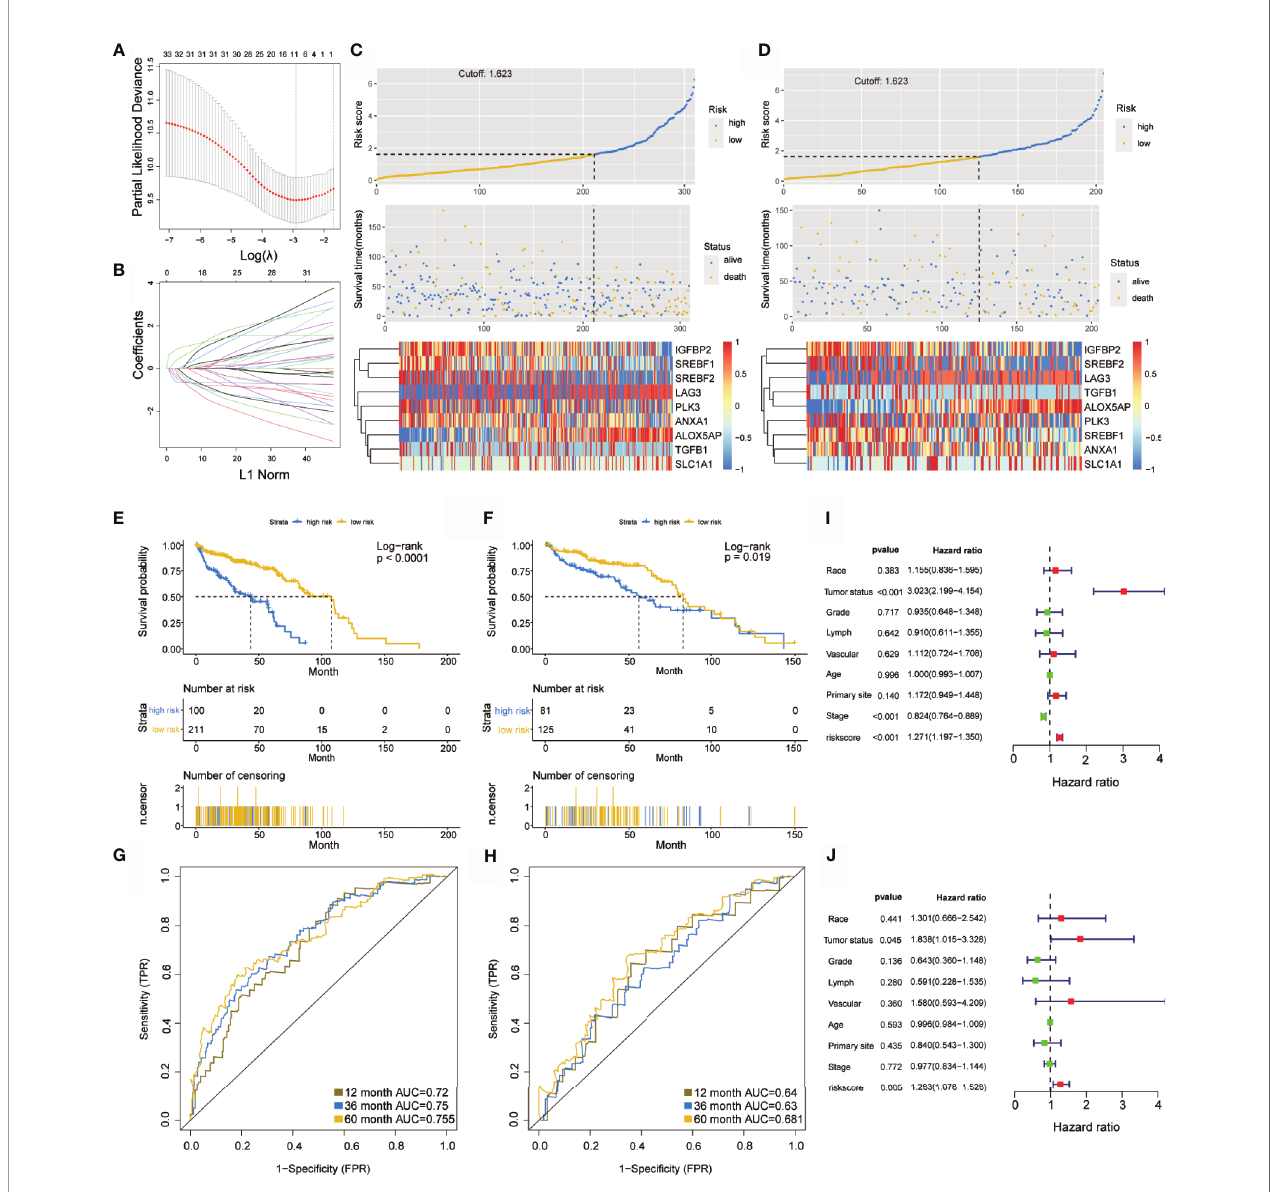
FIGURE 2 | Construction and veri fi cation of the hypoxia prognostic classi fi er. (A, B) Determination of the number of factors using LASSO analysis. (C, D) Risk score distribution, survival overview, and heatmap in patients in the TCGA training cohort (C) and the TCGA internal validation cohort (D) datasets assigned to high- and low-risk groups based on the risk score. (E, F) Kaplan-Meier curve for the TCGA training cohort (E) and the TCGA internal validation cohort (F) . (G, H) ROC curve of the TCGA training cohort (G) and the TCGA internal validation cohort (H) . (I, J) Univariate (I) and multivariate (J) Cox regression analysis of risk score, age, tumor status(with tumor or tumor free), grade, lymphovascular invasion, vascular invasion, primary site and stage. ROC, receiver operator characteristic. AUC, the area under the